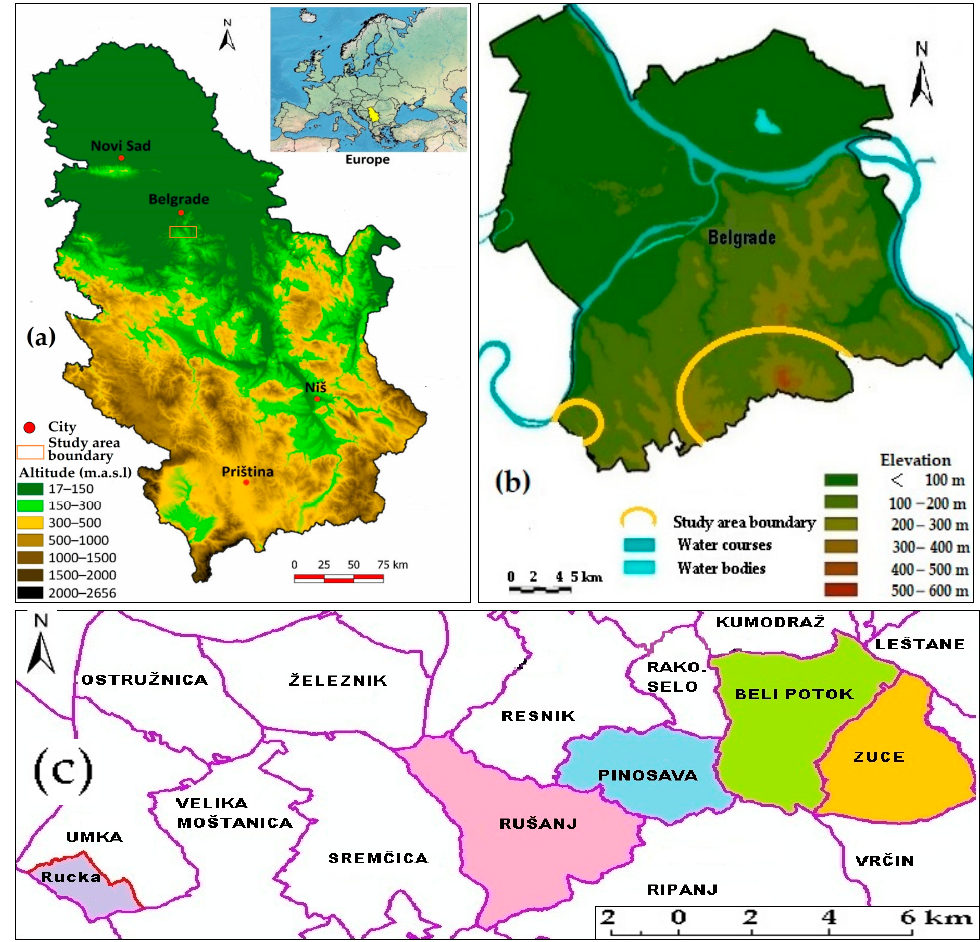
Figure 1. The geographical position of the research area: relief map of Serbia ( a ) [39], relief map of Belgrade ( b ) [40], and study area boundary (5 settlements) ( c ).